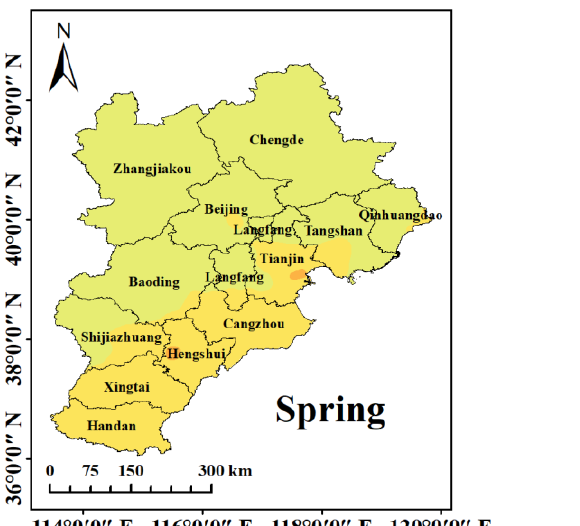
3 concentration. Figure 9. Spatial distribution of annual maximum 8-h average O